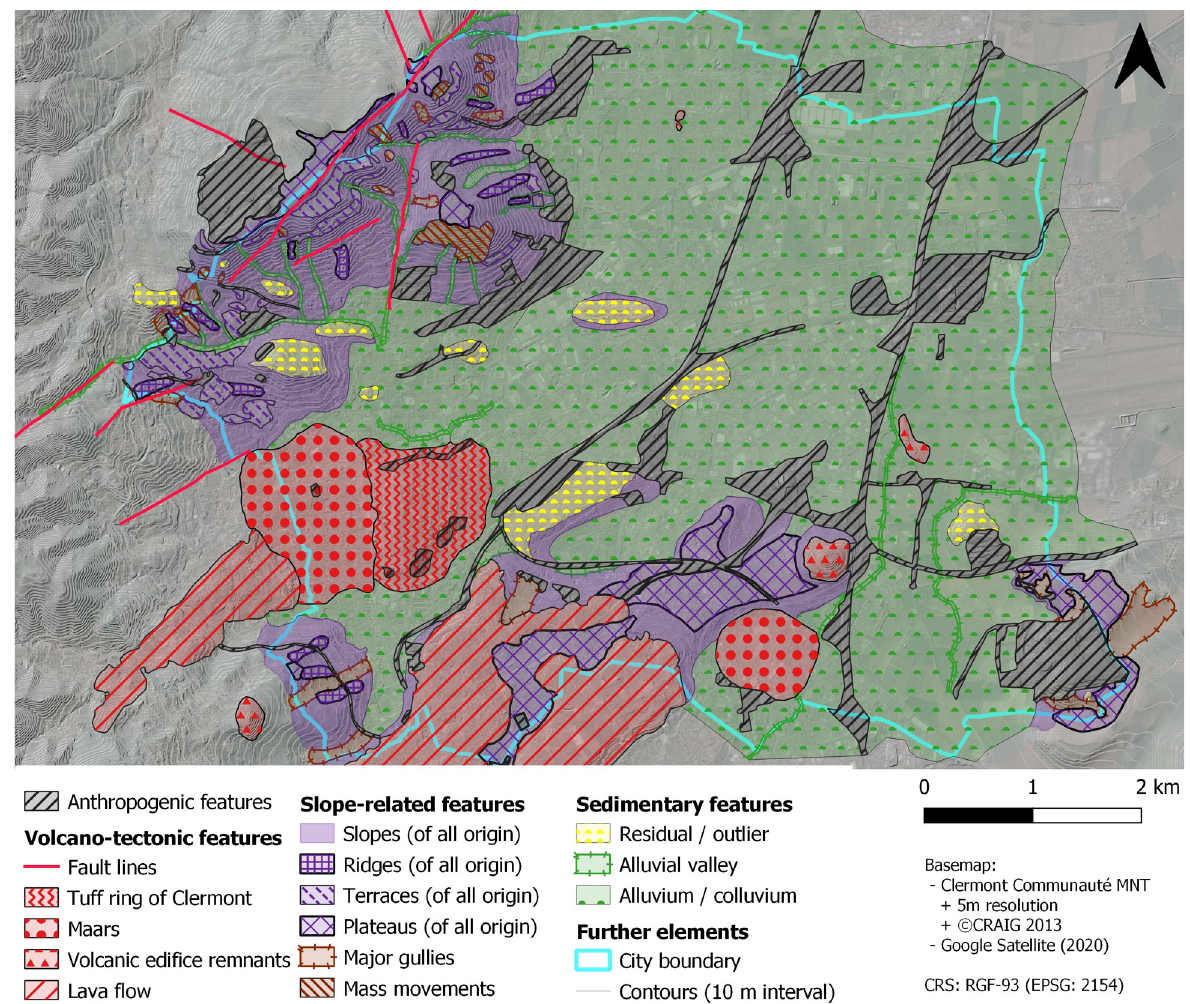
Fig. 3. The simplified geomorphological map of